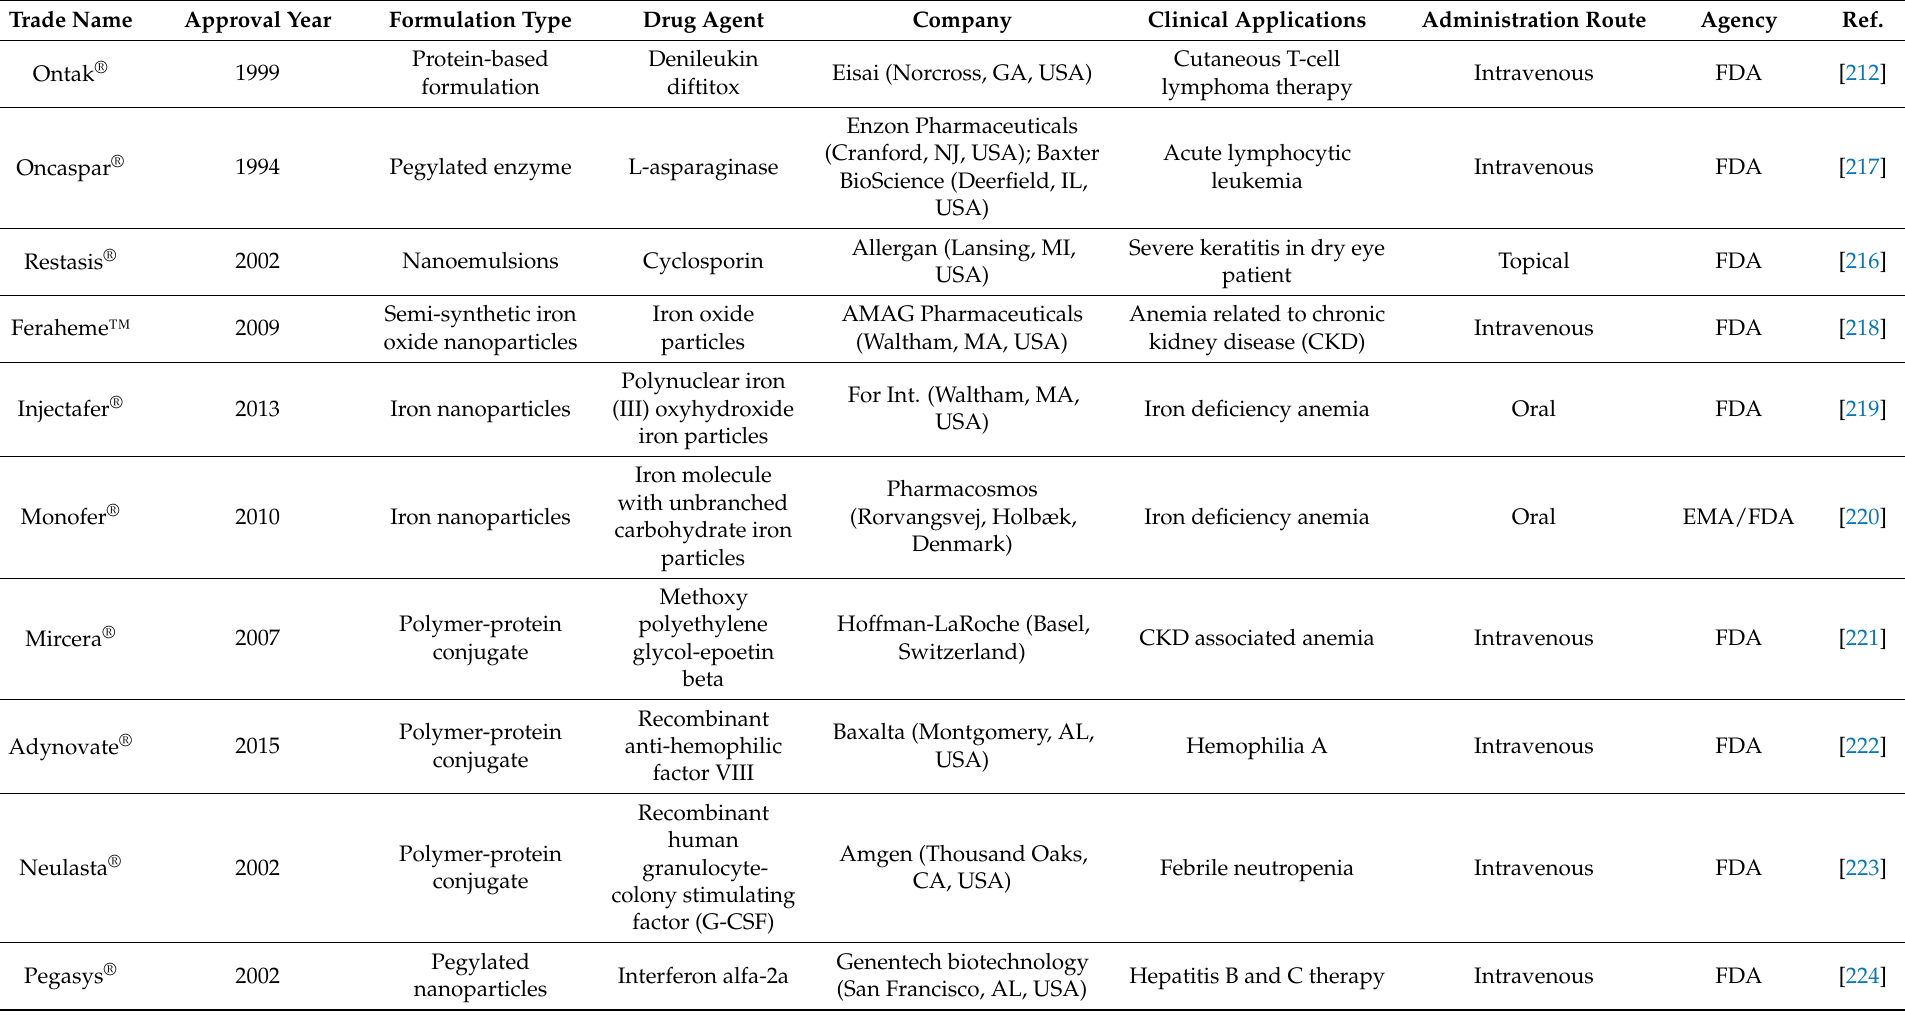
Table 4. Summary of other launched nanomedicine for treating multiple